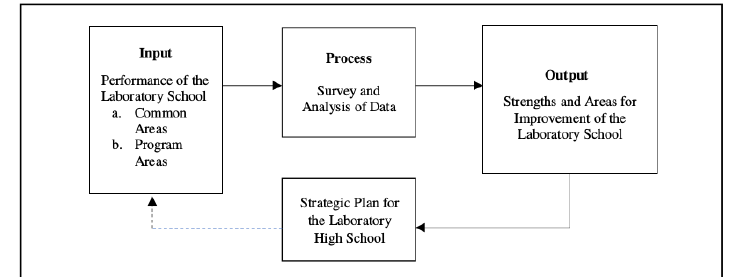
Figure 1: Conceptual